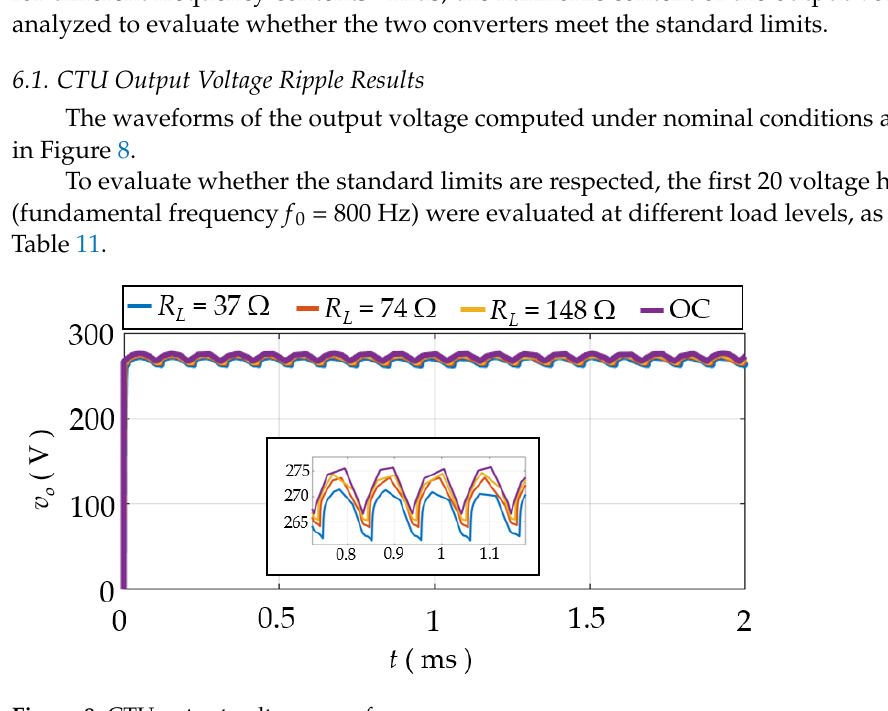
Table 11. The harmonic content of CTU output voltage. DC Ripple